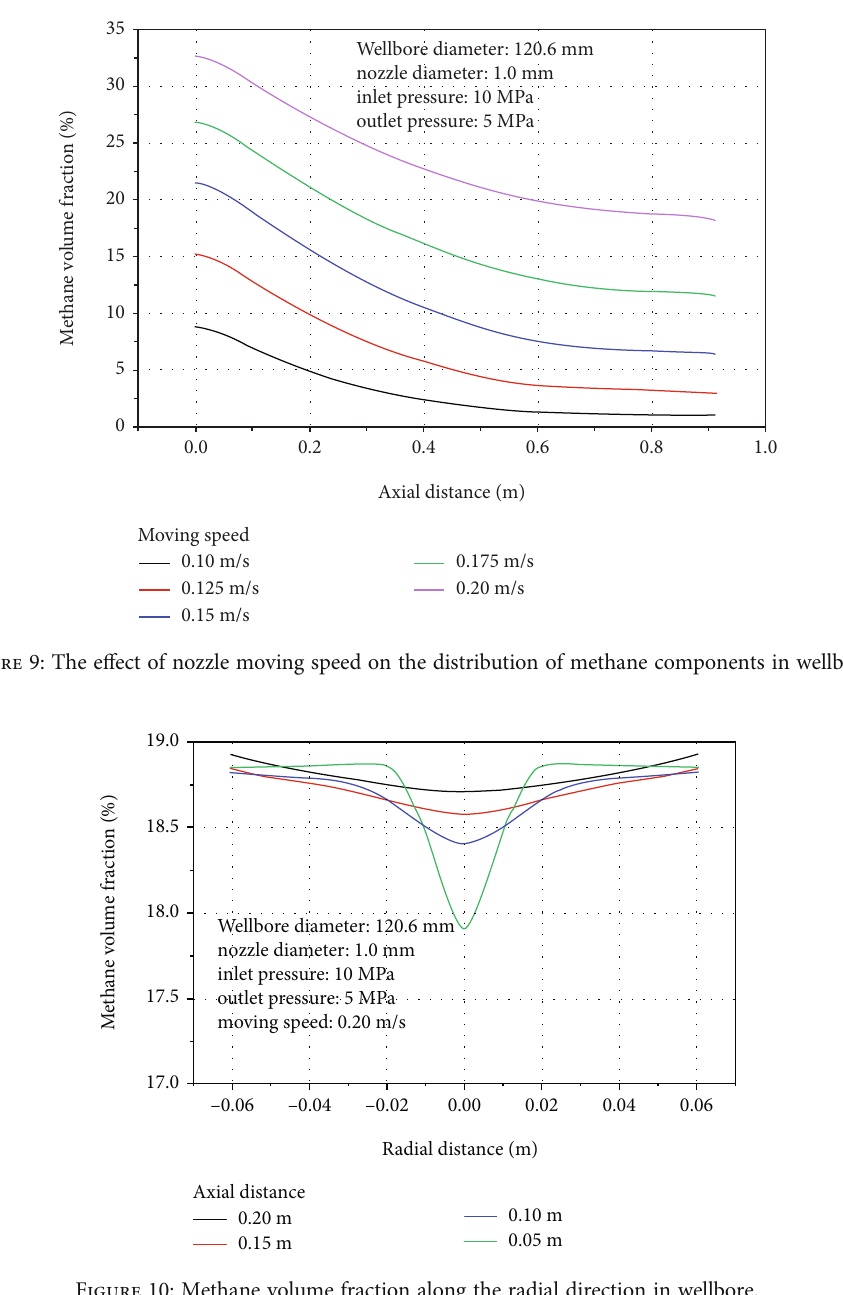
Figure 10: Methane volume fraction along the radial direction in